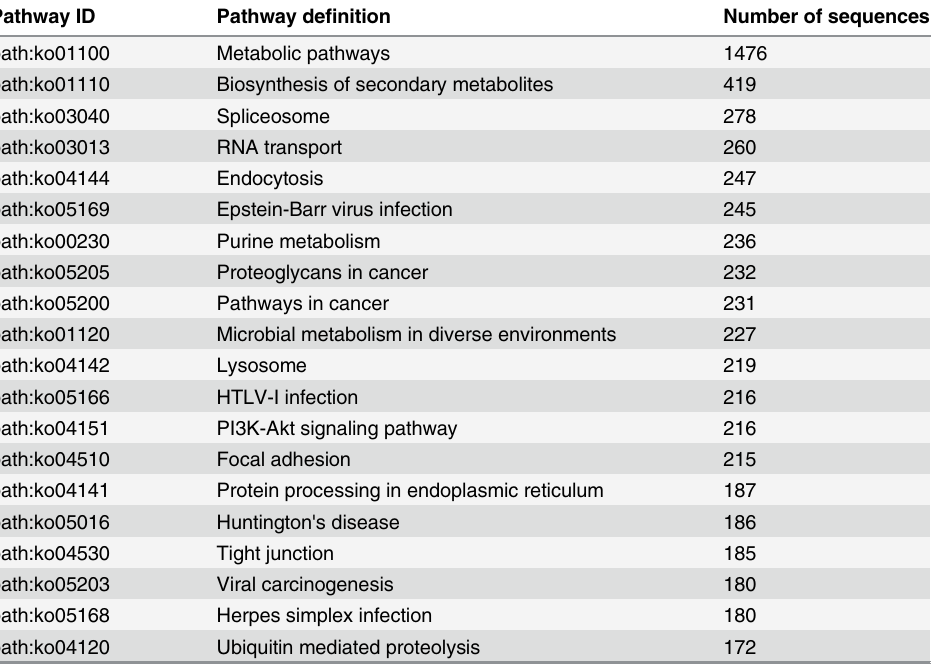
Table 4. The top 20 pathways with the greatest number of annotated sequences.